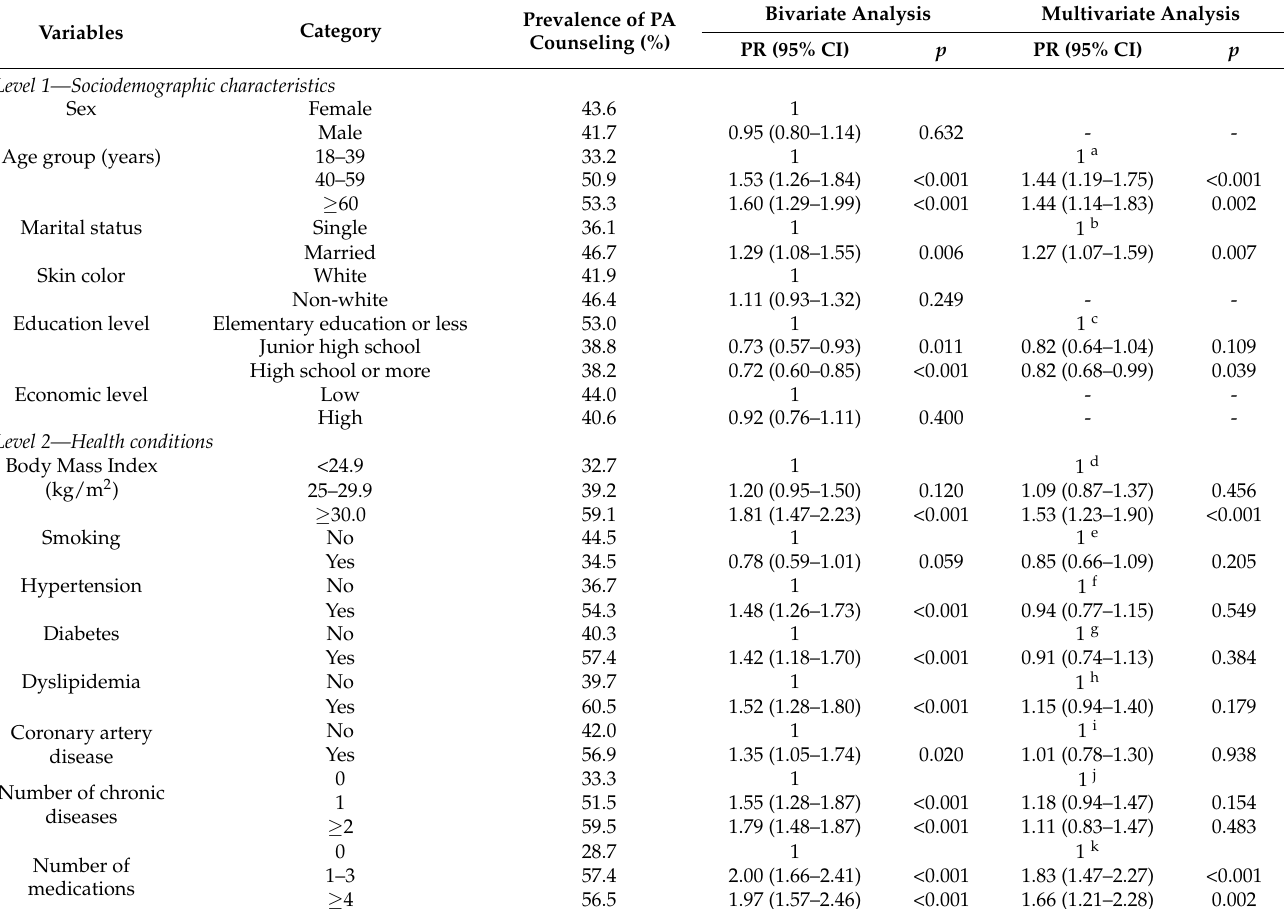
Table 3. Associated factors with physical activity counseling among adults in Primary Health Care units. S ã o Jos é dos Pinhais, Paran á , Southern Brazil, 2019 ( n = 779).